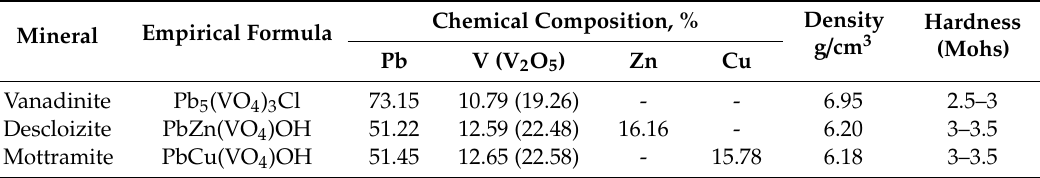
Table 1. General information about major lead vanadate minerals